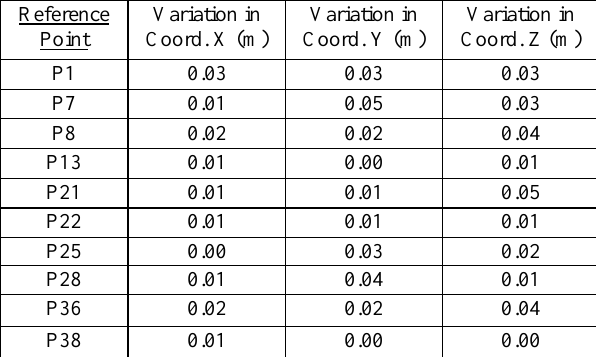
Table 2: Calculation of model accuracy though control points. The errors are in the range of centimeters and the quadratic composition of the errors gives a maximum three-dimensional positional error of 5 cm, and its average 3cm. Therefore, the accuracy reached is 3 cm in the Negro tower model generated.